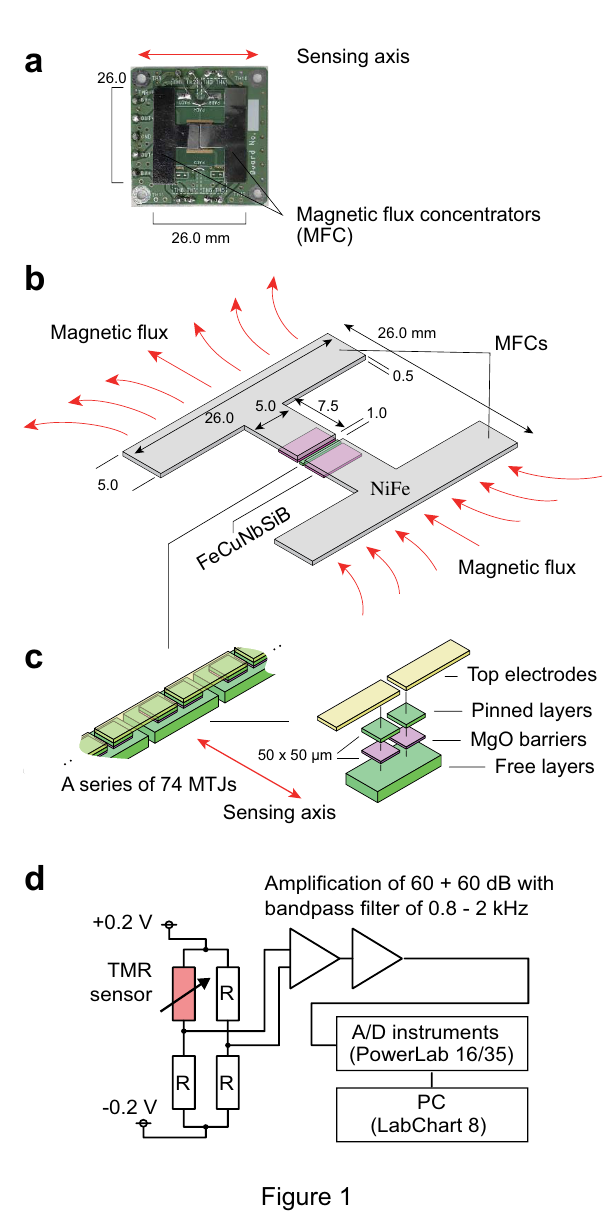
Figure 1. TMR sensor system used for scalp-attached tangential MEG. ( a ) Photograph of a TMR-MEG system consisting of two T-shaped MFCs (black) mounted on a circuit board. ( b ) Schema of two MFCs fabricated by two film deposition of 300 nm-thick FeCuNbSiB in a size of 5.0 mm × 2.5 mm (purple) and a facing pair of T-shaped 0.5 mm-thick NiFe plates with 26.0-mm width (gray) parallel to the array of 74 MTJ (green). ( c ) Partial and magnified schemas of the array of 74 MTJs. Resistance changes, across pinned and free layers (green) separated by thin MgO barriers (purple), represent the scalp surface tangential MEG through MFCs. Size of each free layer in the 74 MTJ arrays is 100 μm × 150 μm × 140 nm. Top electrodes (yellow) connect the MTJs into a bridge circuit, amplifiers, and a signal analysis computer. ( d ) Measurement circuit diagram used for the MEG measurement. A TMR sensor was used as one of the resistors in the bridge circuit, and its output voltage was amplified and filtered. The bridge was supplied with ± 0.2 V, so the bias voltage of about 0.2 V was applied to the TMR sensor. The circuit to receive the signal from the bridge consisted of our homemade amplifiers and capacitor-resistor passive filters. The biomagnetic field signal measured by the TMR sensor was input to a two-stage amplification circuit with a total gain of 120 dB and passed through an analog bandpass filter from 0.8 Hz to 2 kHz. The amplified and filtered signals were recorded on a PC at sampling rate of 10 kHz using an ADInstruments PowerLab 16/35 of 16 bit resolution and LabChart8 software. The magnetic field signals were filtered in the software with a moving average (digital filter) from 20 to 200